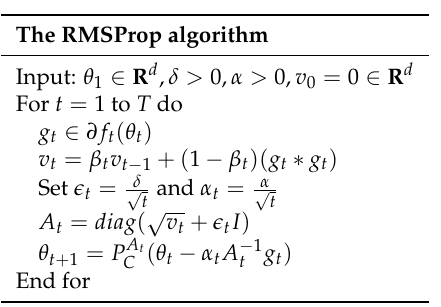
Table 1. The RMSProp